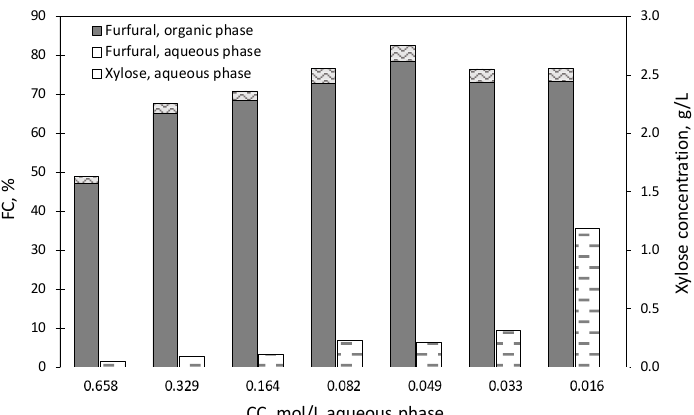
Figure 3. Molar conversions of precursors into furfural, and xylose concentrations in experiments performed at 180 ◦ C using [C3SO 3 Hmim]HSO 4 as a catalyst. Data were obtained for diverse catalyst concentrations in experiments lasting 20